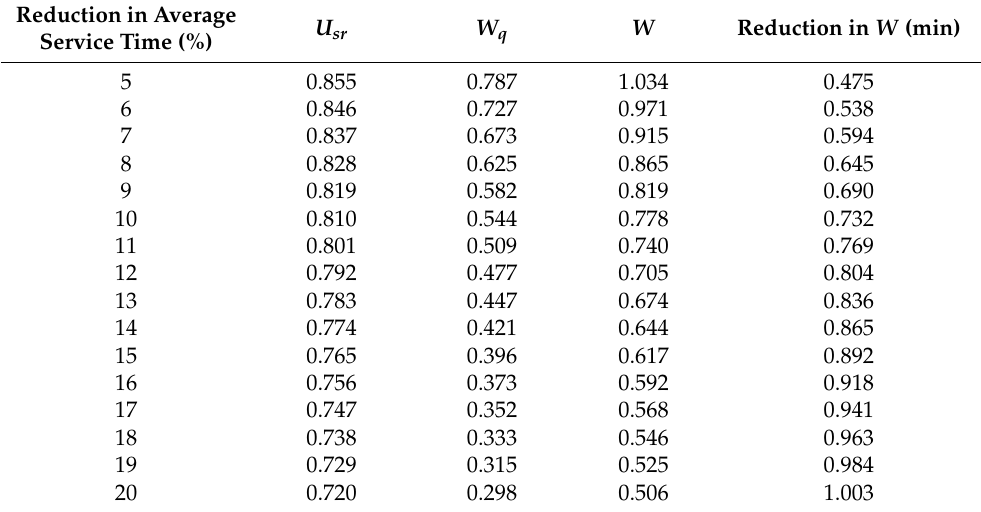
Table 7. The effect of reduction in average service time on savings in W